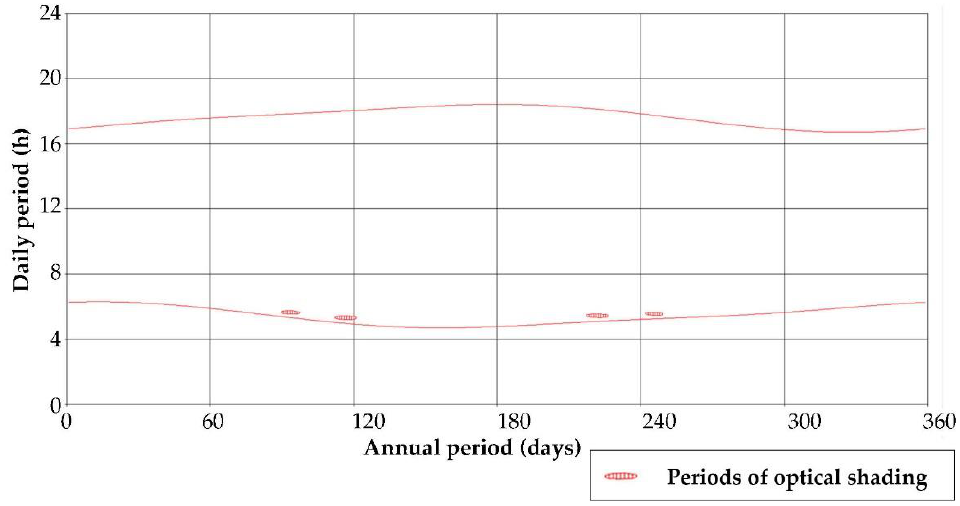
Figure 15. Annual fluctuation of the wind turbines’ optical shading on the settlement of Troullaki.